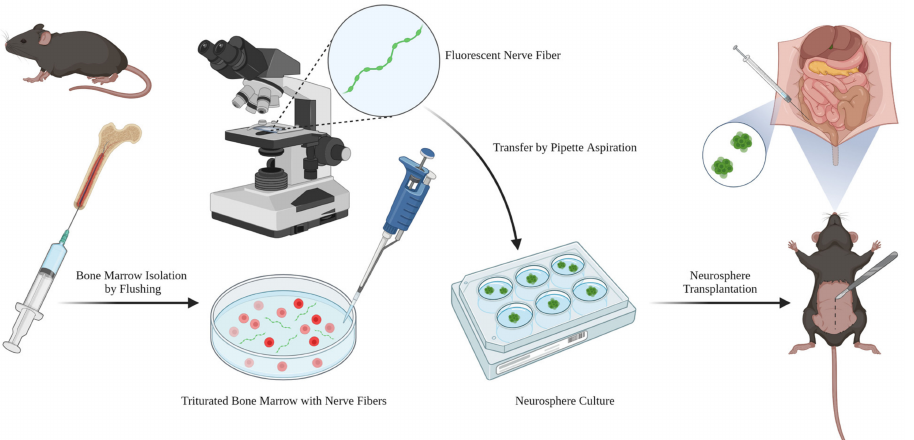
Figure 3. Overview of BM nerve fiber isolation, culturing, and neurosphere transplantation. Adult mice were sacrificed, and the femur, tibia, and pelvis dissected. The BM plug was liberated by flushing the medullary cavity with PBS, then gently triturated to free the nerve fibers from the stroma. Nerve fibers were identified by fluorescent microscopy and transferred to neuroproliferation media for culture by pipette aspiration. For in vivo transplantation experiments, neurospheres were surgically implanted into the colon or colorectum via injection with a microliter